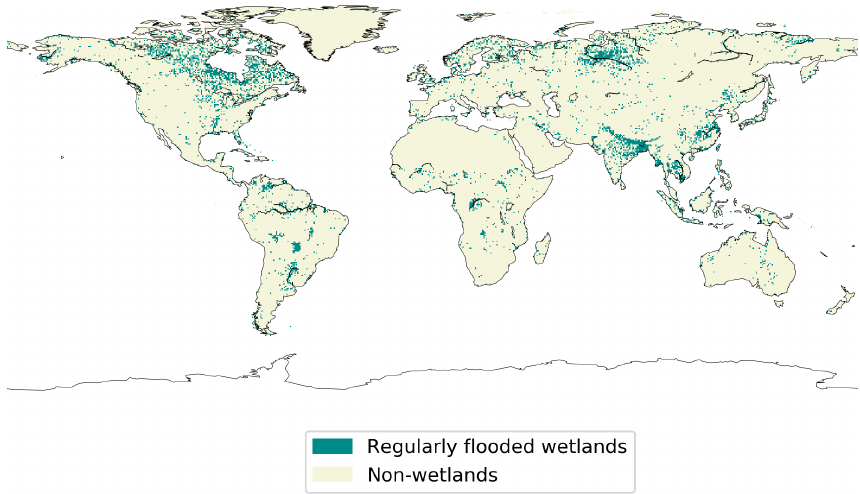
Figure 1. Map of wetlands distribution used to represent anoxic soils in ORCHIDEE. The map resolution is 0.5 ◦ × 0.5 ◦ (adapted from Tootchi et al.,